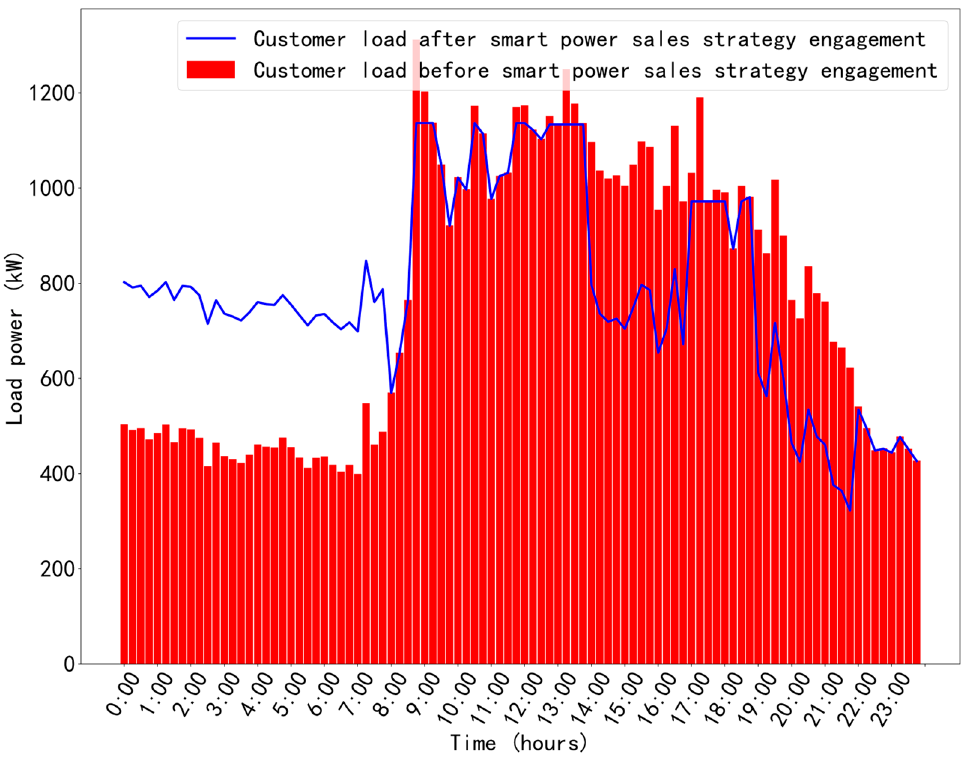
Figure 8. User load before and after a typical daily ESS configuration.